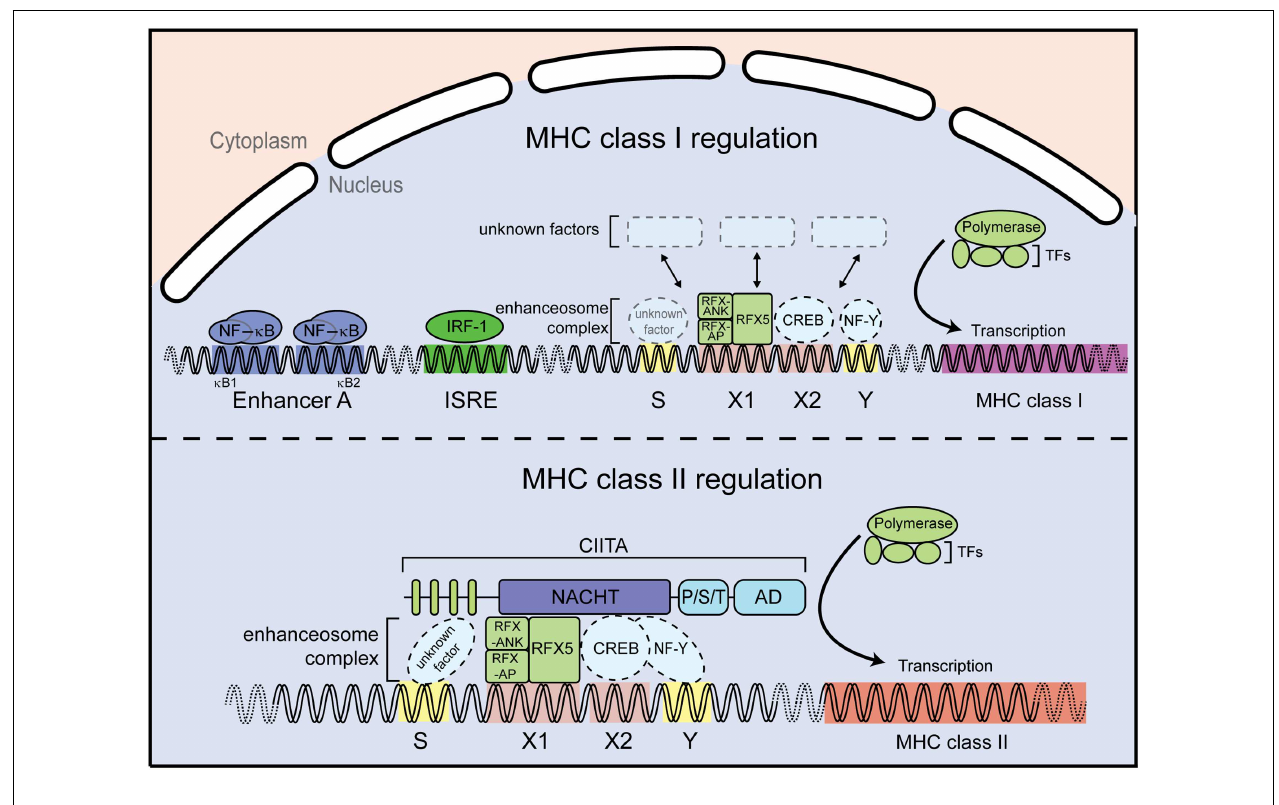
gene contains an SXY module that facilitates assembly of the so-called enhanceosome.The enhanceosome is a protein complex containing regulatory factor X (RFX) proteins, cAMP response element-binding protein (CREB), and the nuclear factorsY (NF-Y).The assembly of this protein complex constitutes a platform for the recruitment the class II transactivator CIITA. Additional abbreviation: RFX-AP, RFX-associated protein; RFX-ANK, RFX-associated ankyrin-containing protein;TFs, transcription